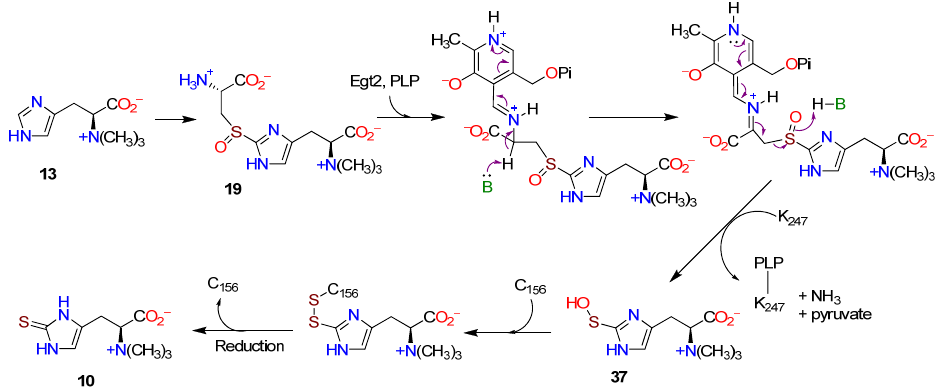
Figure 8. Postulated pathway from hercynine ( 13 ) to ergothioneine ( 10 ) involving PLP (adapted from ref. [38]).